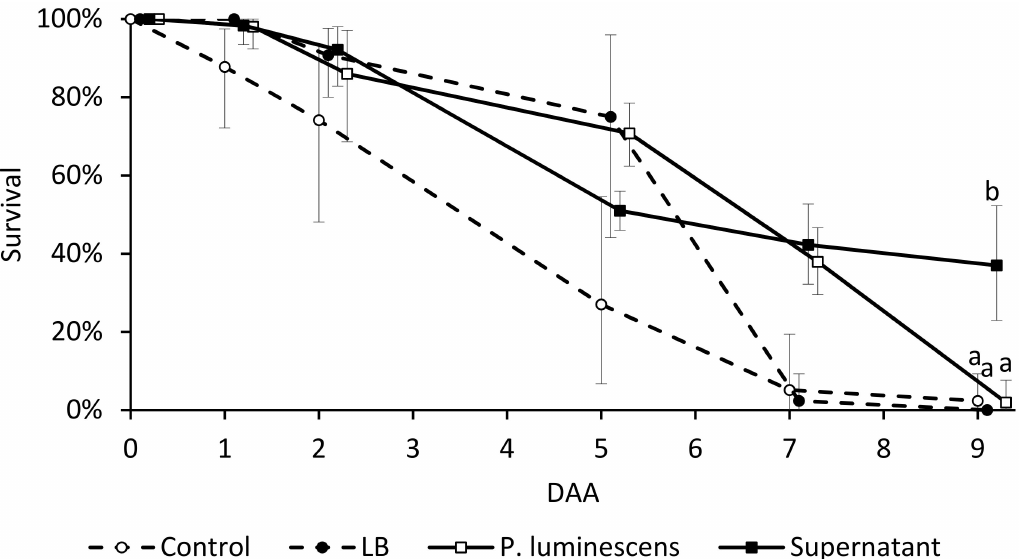
Figure 2. Drosophila suzukii adult survival (average and CI from n = 3 samples) in tubes treated with Photorhabdus luminescens (10 6 cells mL − 1 ) or P. luminescens culture supernatant over 9 days after application (DAA). Survival rates were compared to 10 mM MgSO 4 (control) or axenic Luria–Bertani (LB) medium. Different letters show significant differences among different treatments for each day, according to LSD test; p < 0.05.